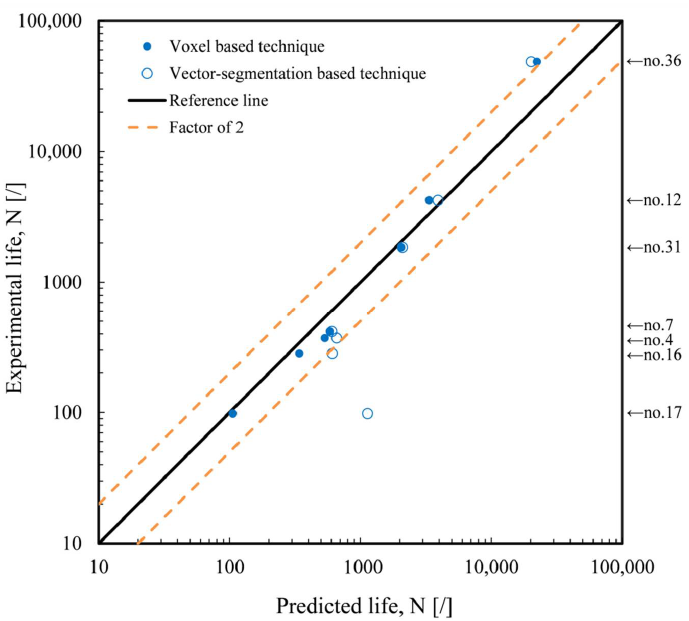
Figure 11. Comparison of experimentally determined and numerically predicted fatigue lives for porous specimens.